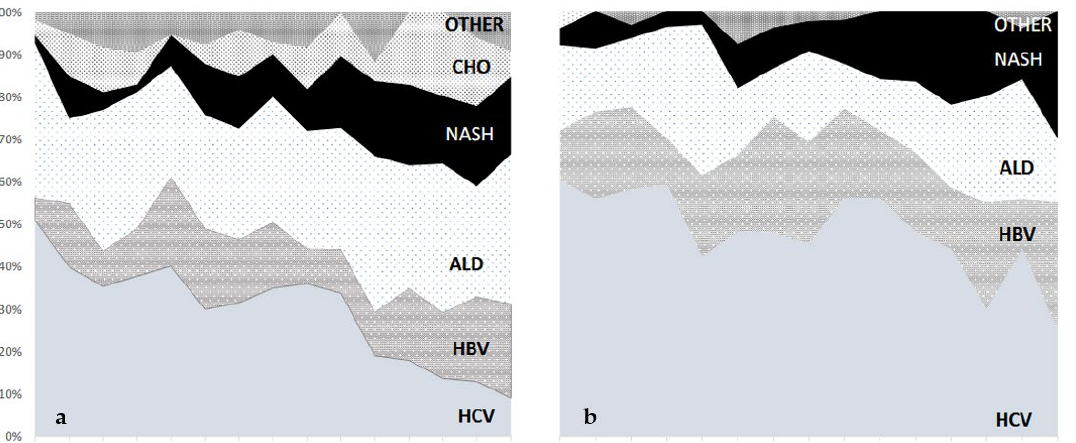
Figure 2. ( a ) Trends in waiting list registrations for patients with decompensated cirrhosis. ( b ) Trends in waiting list registrations for patients with hepatocellular carcinoma on compensated cir- rhosis. The area depicted with a vertical b/w line accounts for other indications. Abbreviations. ALD: alcoholic liver disease; CHO: cholestatic/autoimmune disease; HBV: hepatitis B virus; HCV: hepa- titis C virus; NASH: non-alcoholic steatohepatitis.